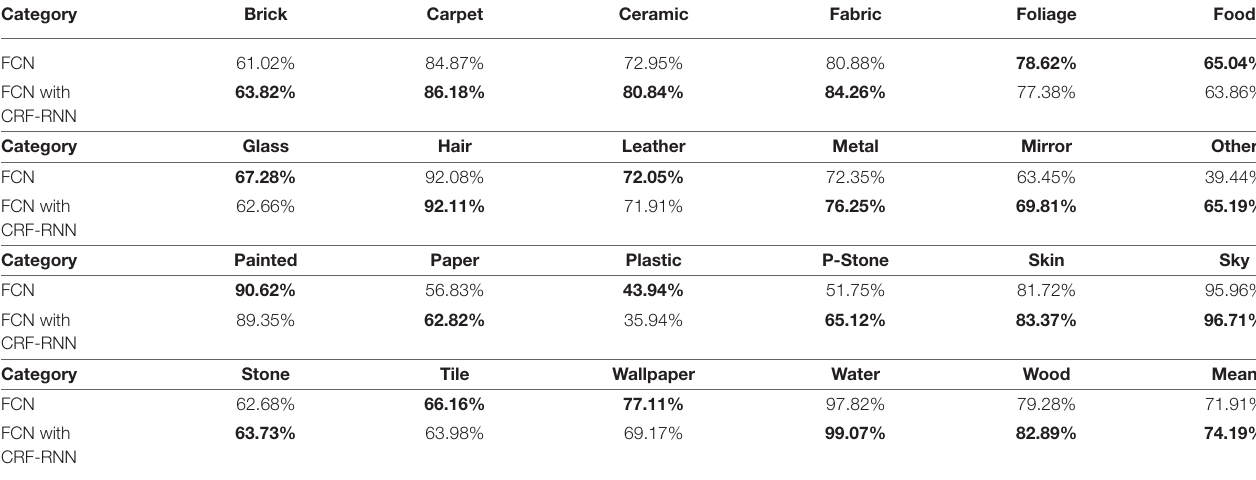
The best performance among the compared methods is in bold. P-Stone, Polished Stone.